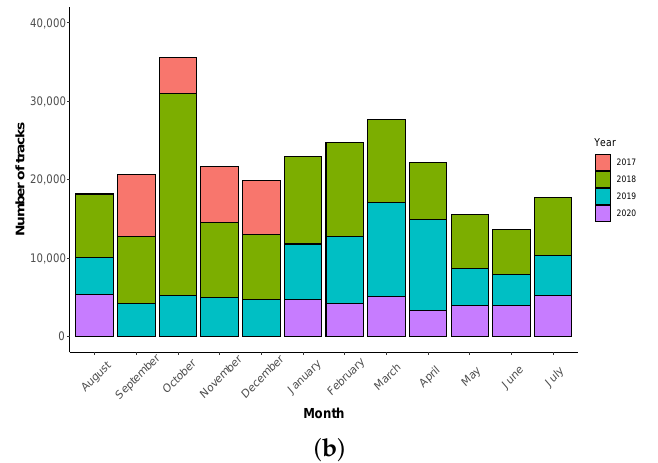
Figure 10. Distribution of track measurements in function of the day and the month, over the 3 years of the collected data. ( a ) Distribution of tracks per day of the week. ( b ) Distribution of tracks per month.